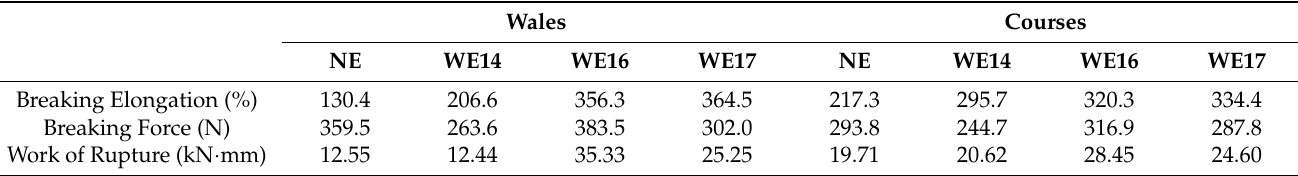
Table 3. Mean values of elongation at break, breaking force, and work of rupture for the non-elastane knitted fabrics and with a percentage of wrapped elastane.